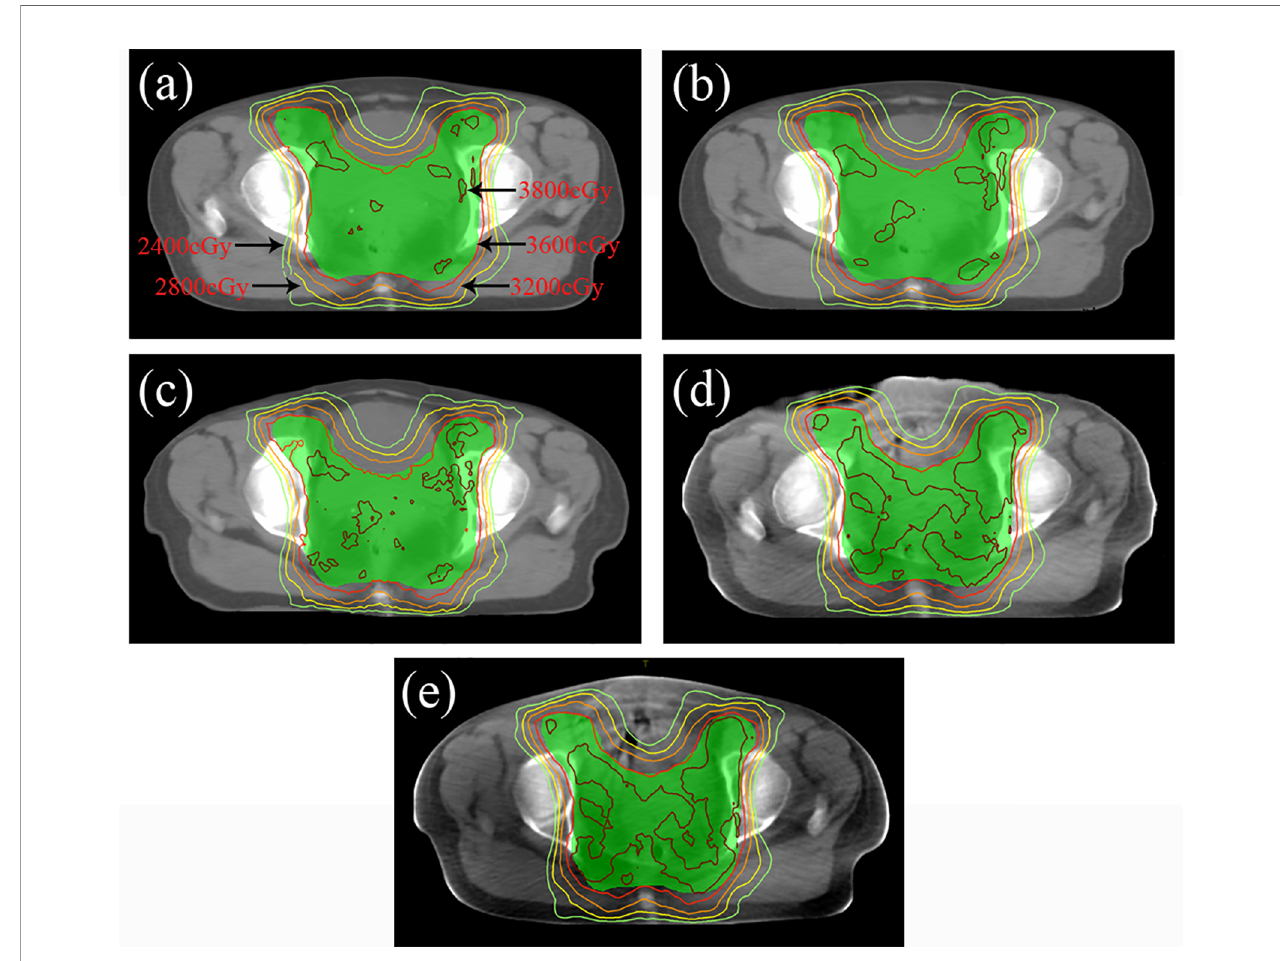
FIGURE 8 | Dose distribution of radiotherapy plan based on four CT images at the isocenter level. (A) Dose distribution of CT gt at isocenter. (B) Dose distribution of CT CycleGAN at isocenter. (C) Dose distribution of CT unet-GAN at isocenter. (D) Dose distribution of CT FCN-GAN at isocenter. (E) Dose distribution of CBCT at